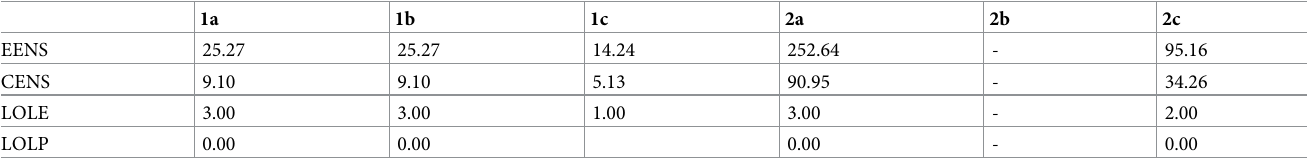
Table 11. Influence of DR on reliability.